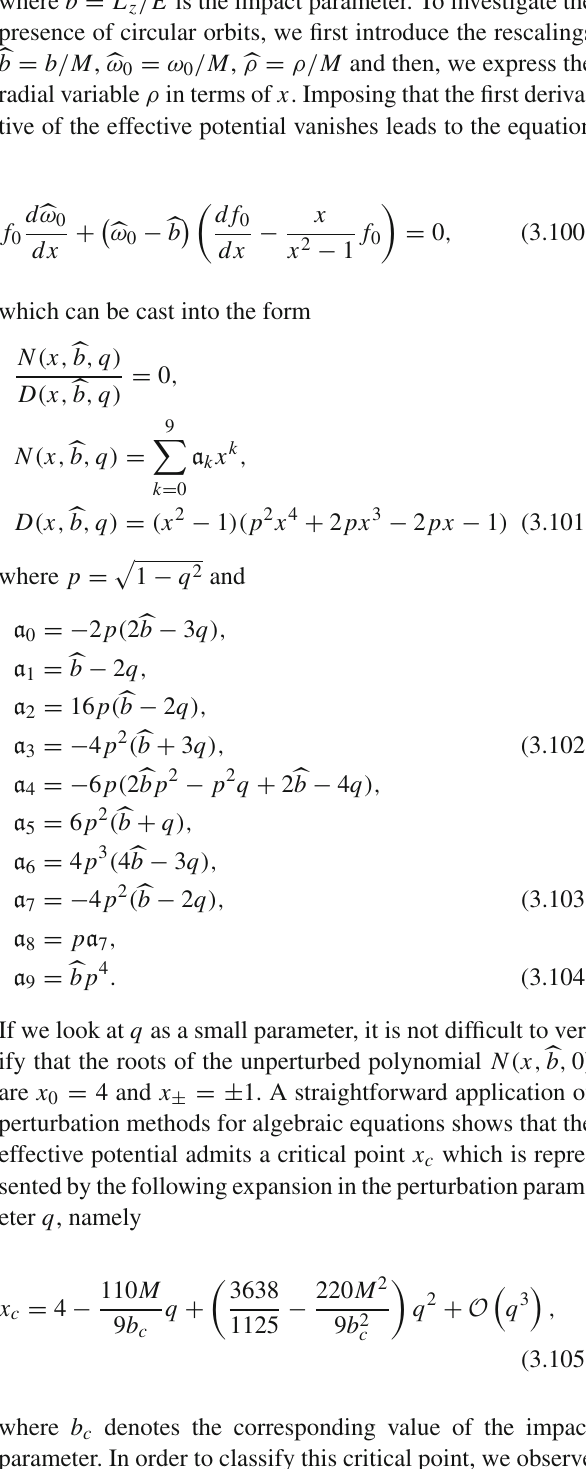
Fig. 1 for different values of the parameter q those regions in the ( x , y ) -plane (yellow colour) where the refractive indices (3.90) are